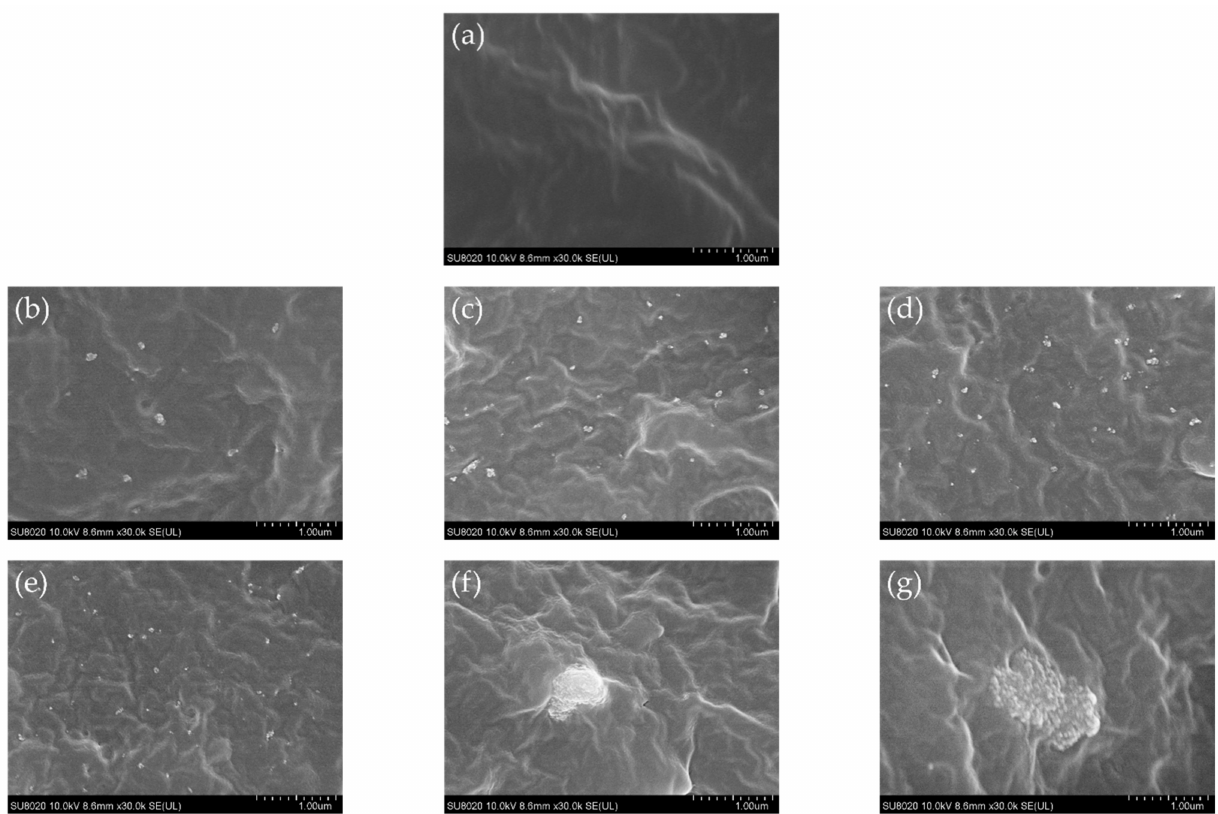
Figure 2. SEM images of PP nanocomposites with different NKT90/P90 contents. ( a ) PP; ( b ) PP + 0.5%NKT90; ( c ) PP + 1%NKT90; ( d ) PP + 1.5%NKT90; ( e ) PP + 2%NKT90; ( f ) PP + 0.5%P90; ( g ) PP +